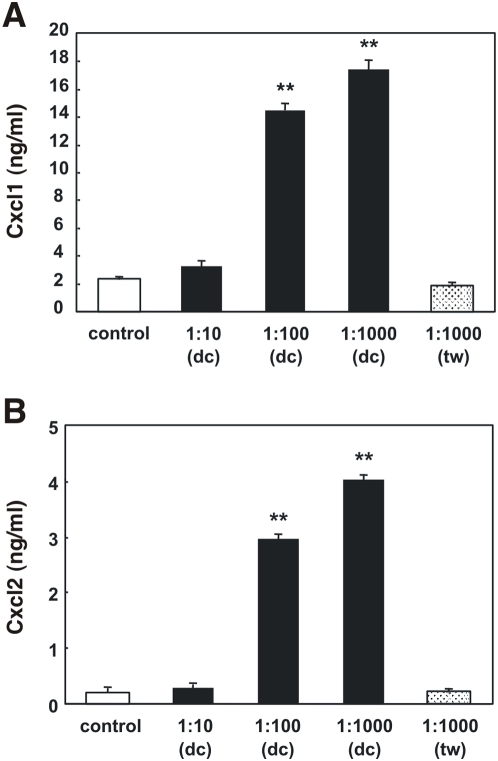

H. muridarum induces CXC chemokine production in m-ICcl2 cells by a contact-dependent mechanism.m-ICcl2 cells were either left unstimulated (control) or stimulated with different amounts (expressed as the MOI) of live H. muridarum ATCC49282 bacteria. The bacteria were incubated in direct contact (dc) or separated from the cells by a transwell (tw) filter membrane. The levels of secreted (A) Cxcl1 and (B) Cxcl2 were measured in culture supernatants at 48 h post-stimulation. Data correspond to the mean±SD (triplicate determinations). Statistical differences were observed between Cxcl1 or Cxcl2 levels following bacterial stimulation compared to control cells (**, P≤0.0002).